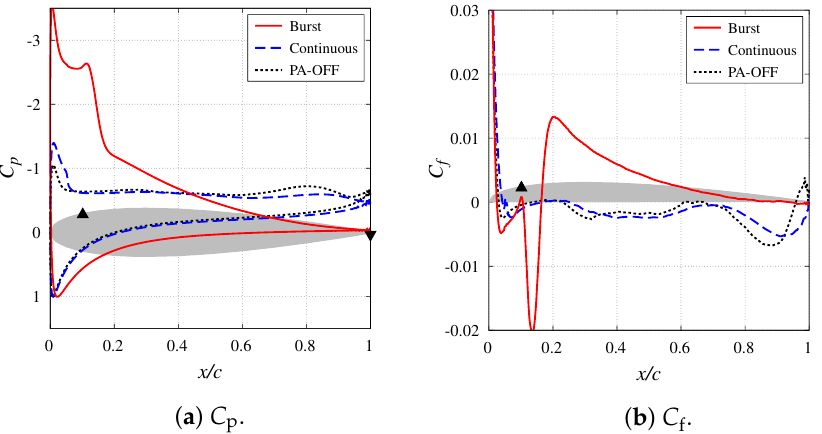
Figure 19. Pressure coefficient ( C p ) and skin friction coefficient ( C f ) distributions on the airfoil’s upper surface at α =